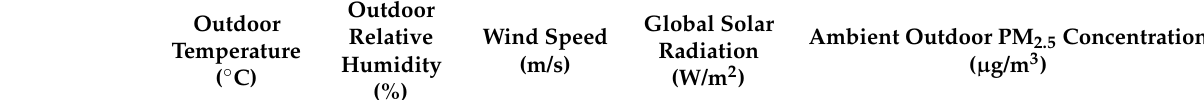
Table A3. The descriptive statistics of the key environmental variables for individual districts.